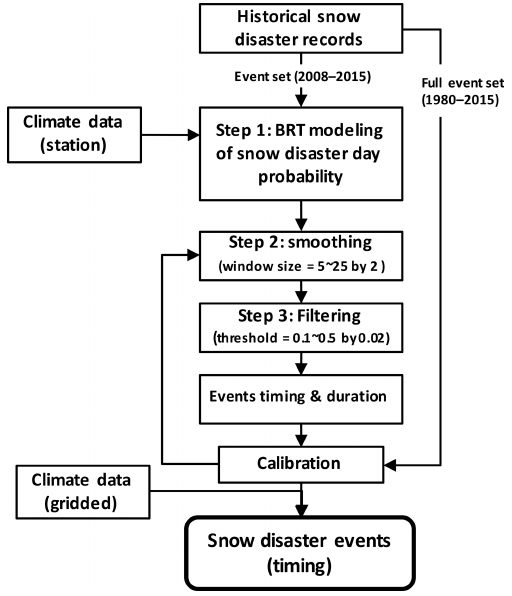
Figure 2. Technical flow of the snow disaster event identifier–